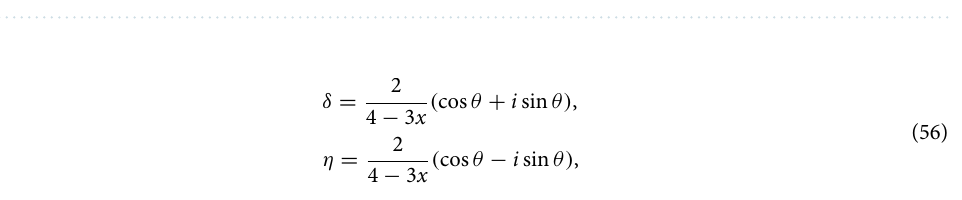
r 0 varying with variables (cid:31)